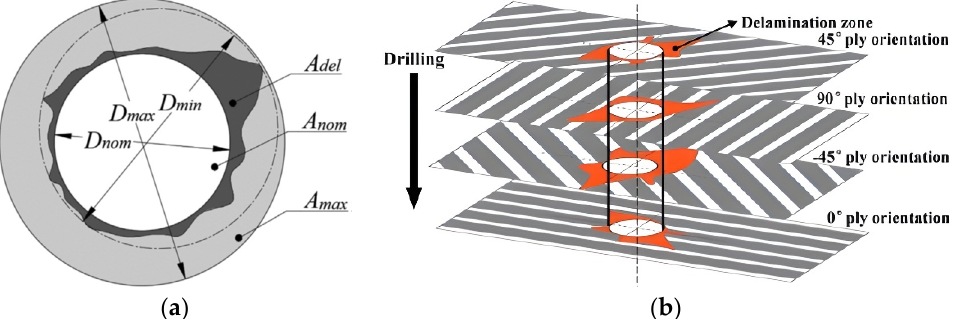
Figure 2. Drilling-induced hole damage of CFRP: ( a ) dimensional characteristics (diameters and areas) used to determine 1D and 2D delamination factors; ( b ) interlaminar delamination [71].